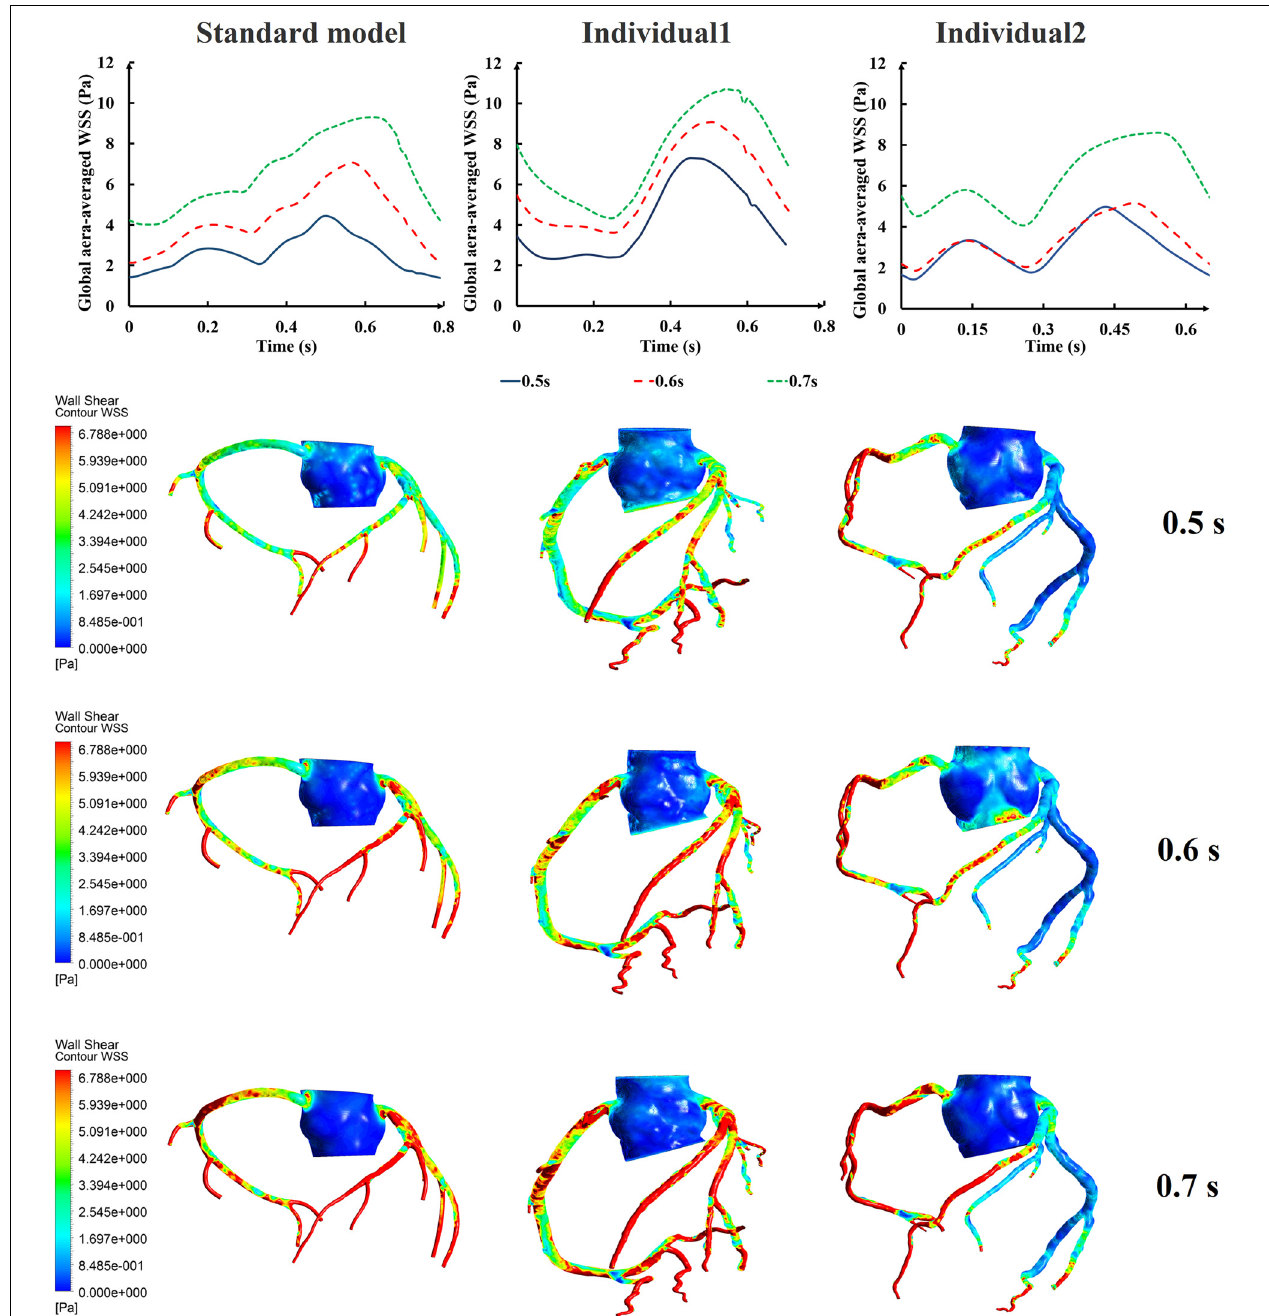
FIGURE 8 | The variations of global area-averaged WSS and the maximum flow moment WSS of three coronary arteries under different pressurization durations.